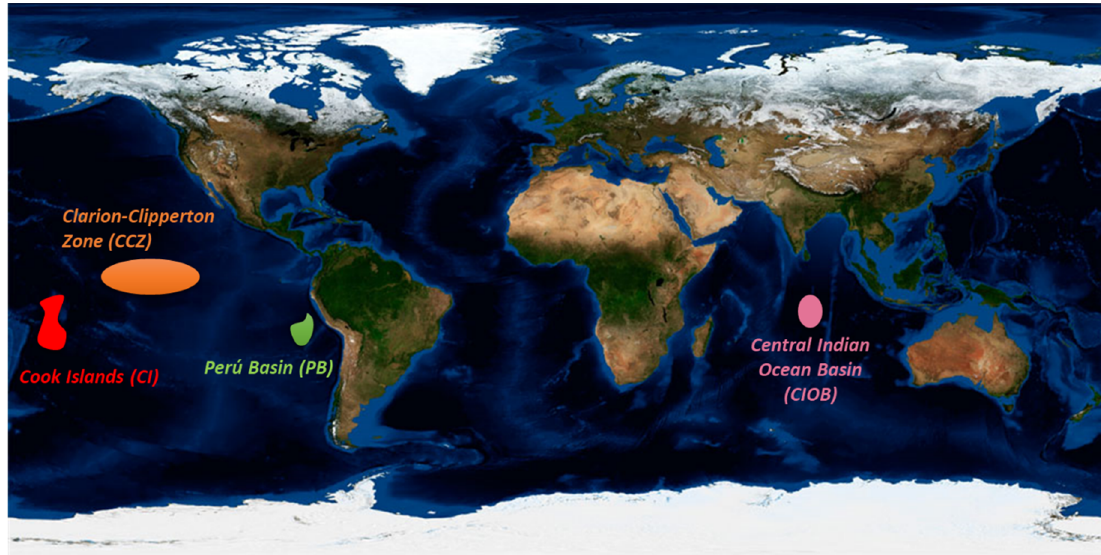
Figure 3. Areas with deposits rich in manganese nodules (modified from Freepik [28]).